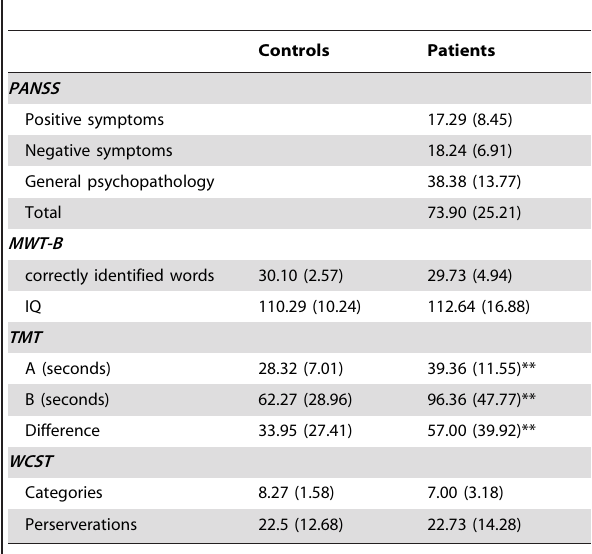
Table 1. Overview of mean clinical and cognitive scores for patients and